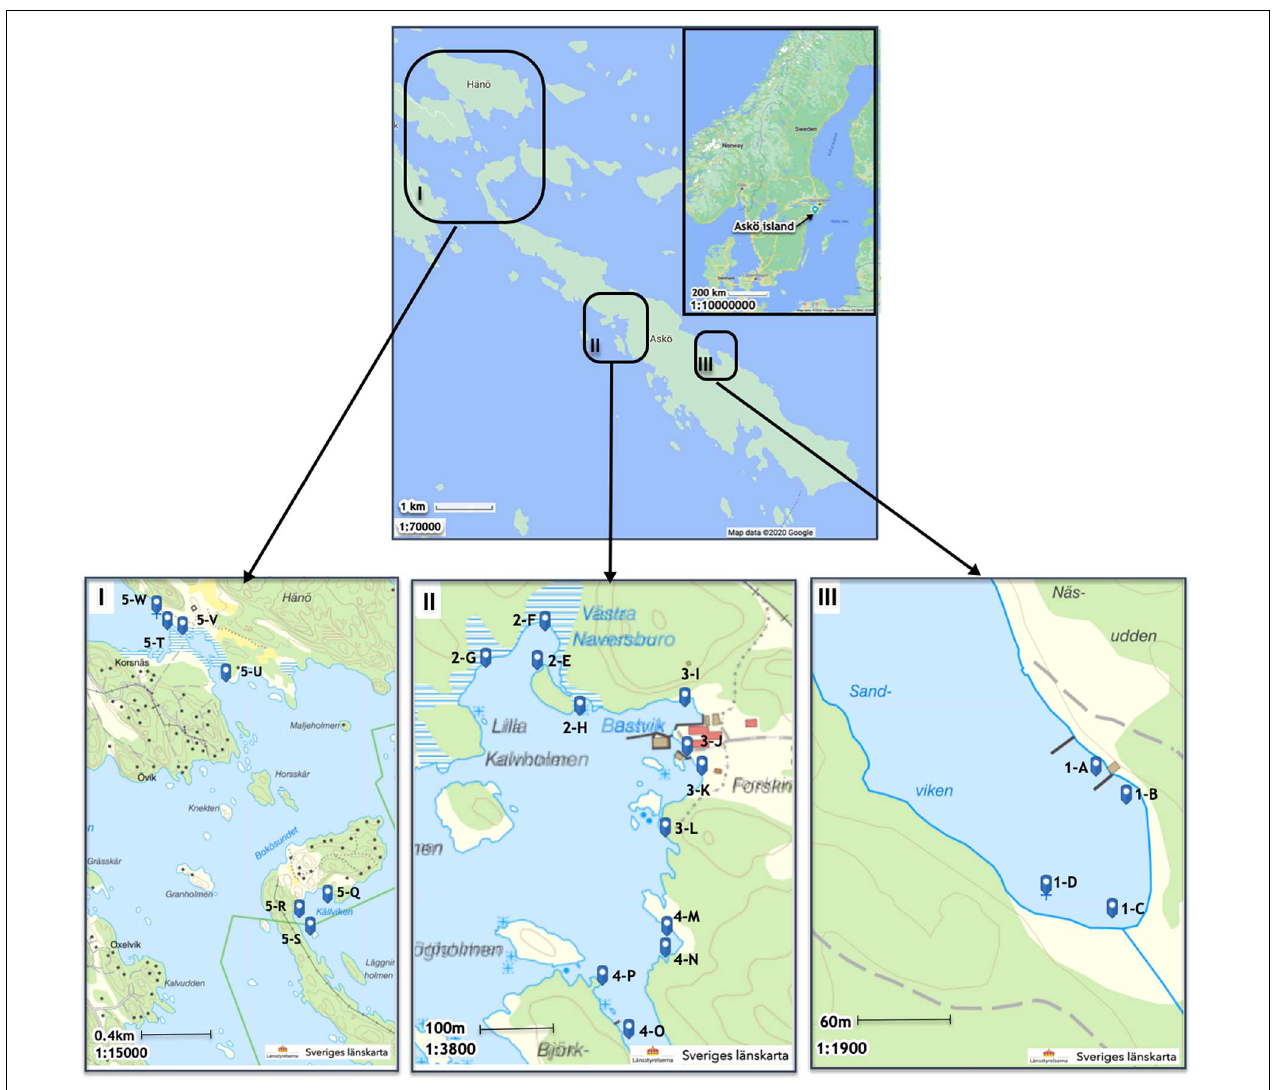
FIGURE 1 | Map of Askö island and the locations of the five sampling areas.